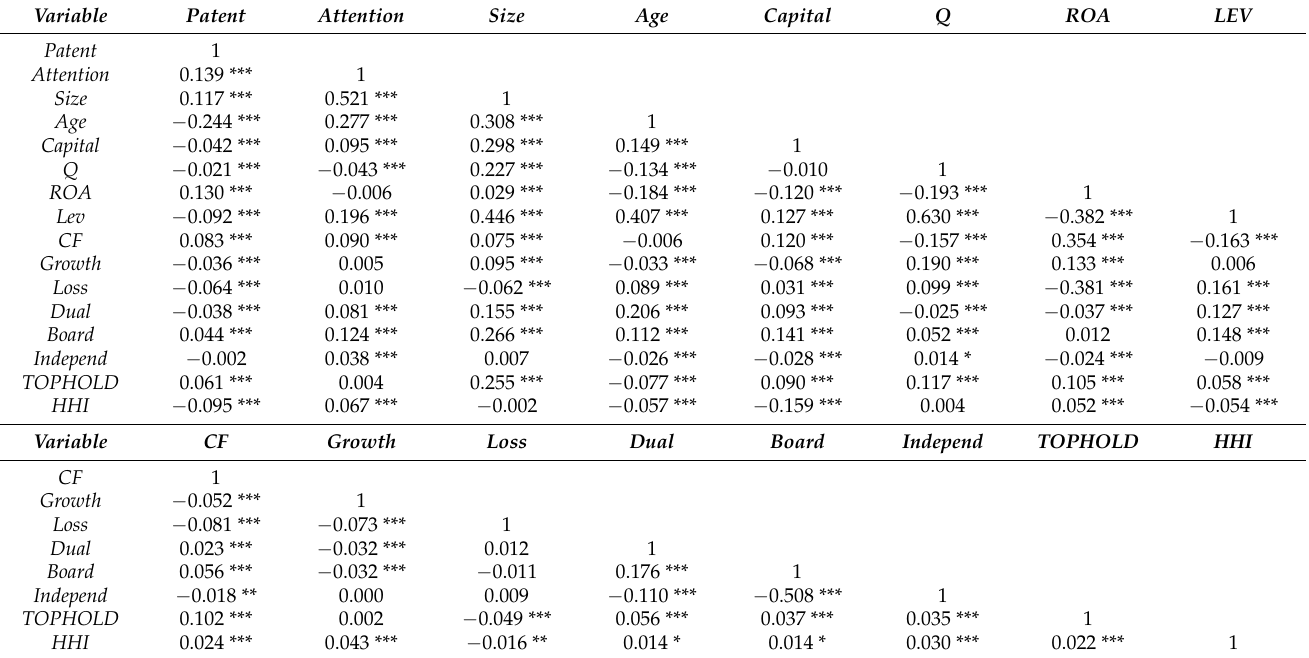
Table 2. Correlation